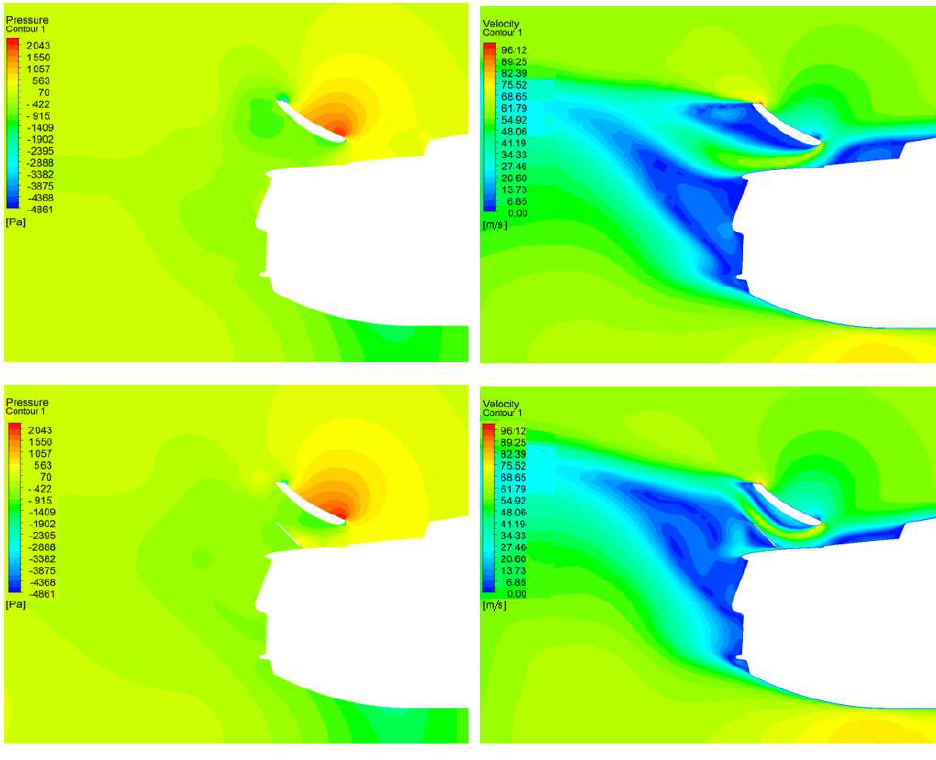
Figure 14. Pressure and velocity distribution around splitter ( top —without support plate, and bottom —with support plate).